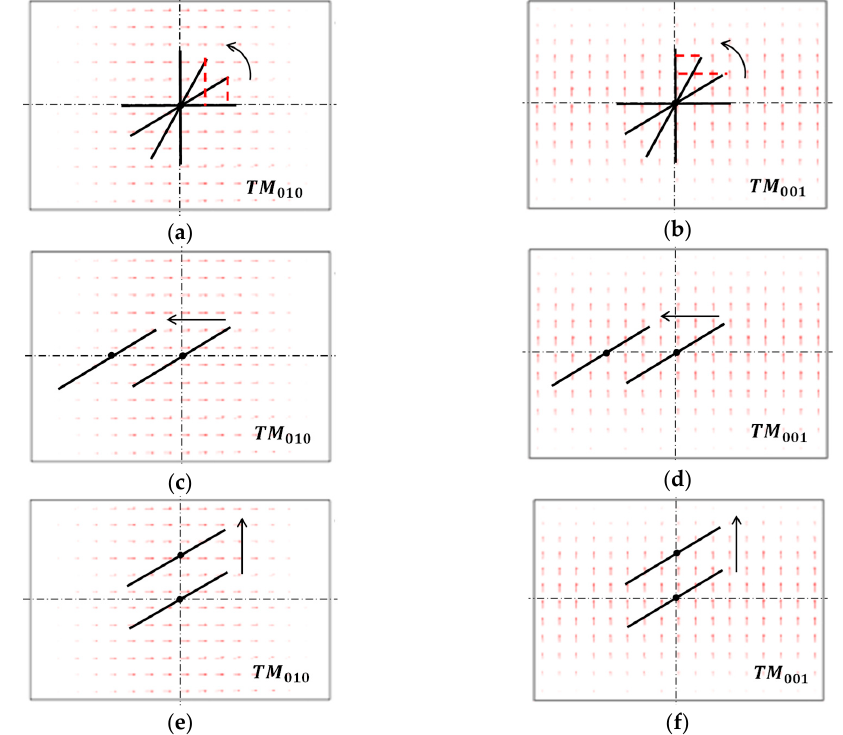
Figure 6. Interaction between the crack and the sensor’s current flow. ( a , b ) cutting effect of the cracks at ground plane center on both current flows; ( c , d ) cutting effect of the crack moving leftwards; ( e , f ) cutting effect of the crack moving upwards.